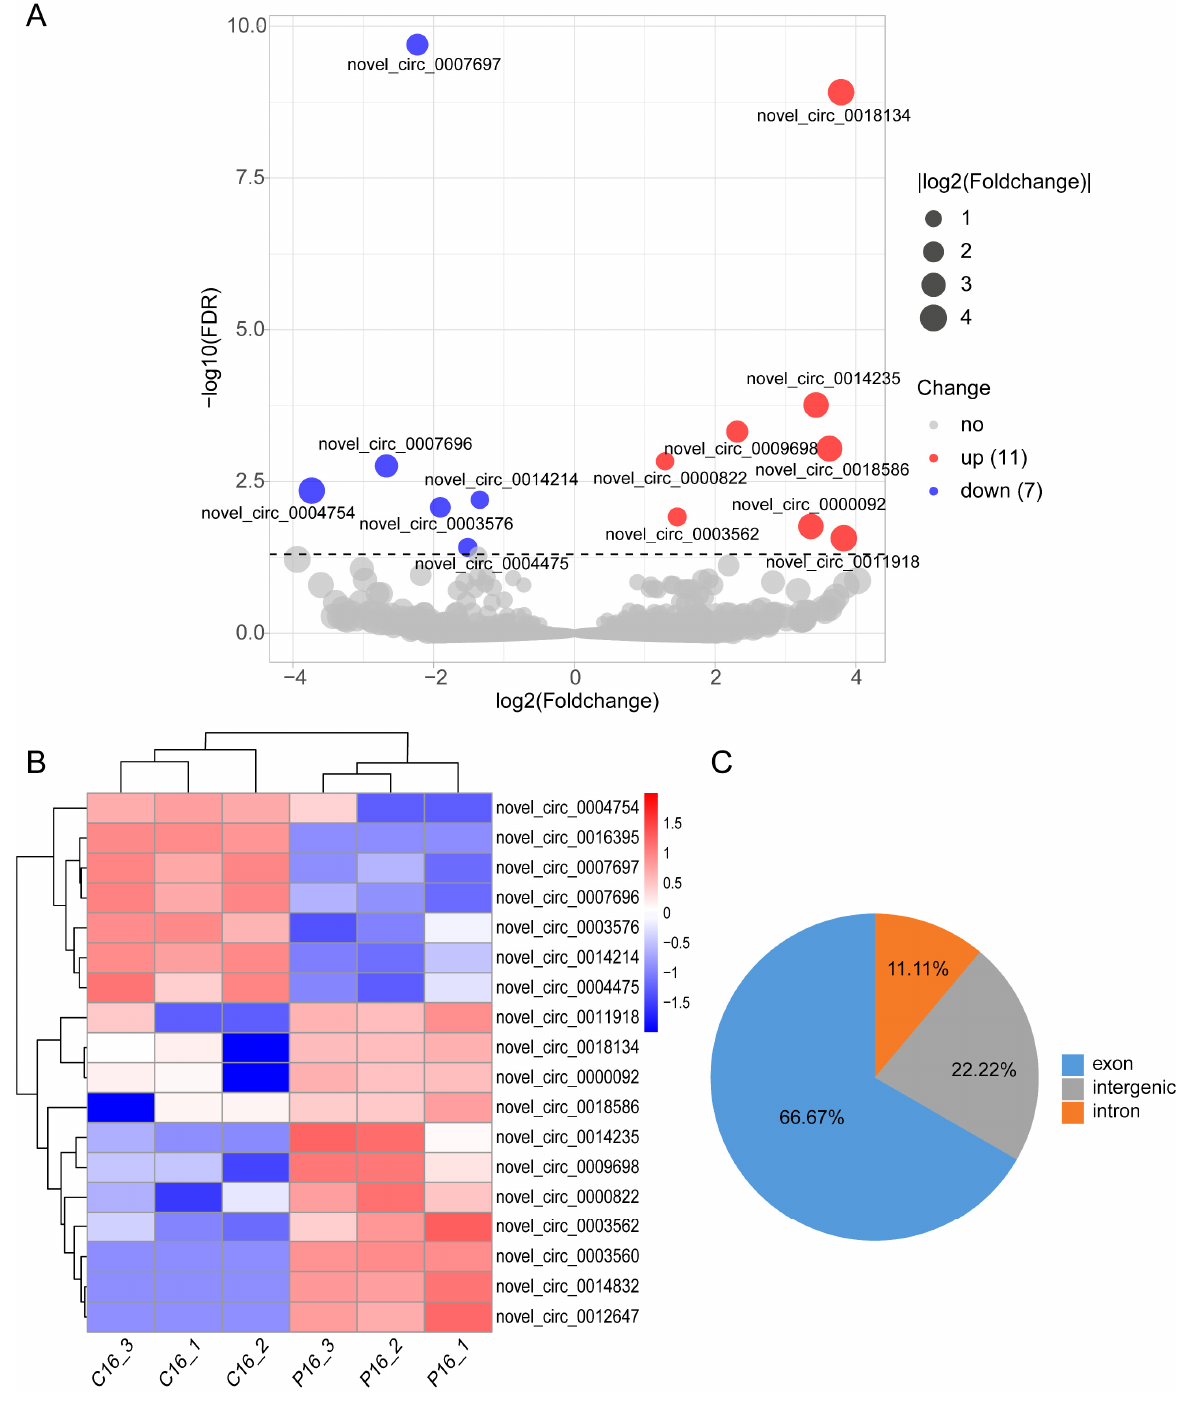
Figure 4. The detected DE-circRNAs in goat endometrium. ( A ) Volcano plot visualization of the statistical difference of the DE-circRNAs. The horizontal axis represents the fold-change of detected circRNAs, and the vertical axis represents the FDR. Red, up-regulated circRNAs; blue, down-regulated circRNAs; gray, not significantly changed circRNAs. ( B ) Hierarchical clustering shows the expression profiles of all DE-circRNAs. Each row represents one DE-circRNA, while columns represent different samples. The color scale is from -2.0 (blue, lower circRNA expression level) to 2.0 (red, higher circRNA expression level). ( C ) The pie chart shows the genic distribution of DE-circRNAs.